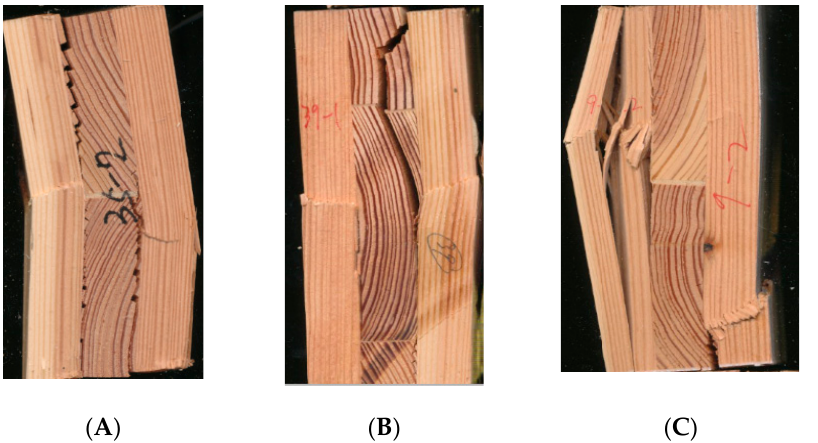
Figure 2. The main forms of the damage of the CLT samples. (The three main forms of the damage for CLT were shown as ( A ), ( B ) and ( C )).